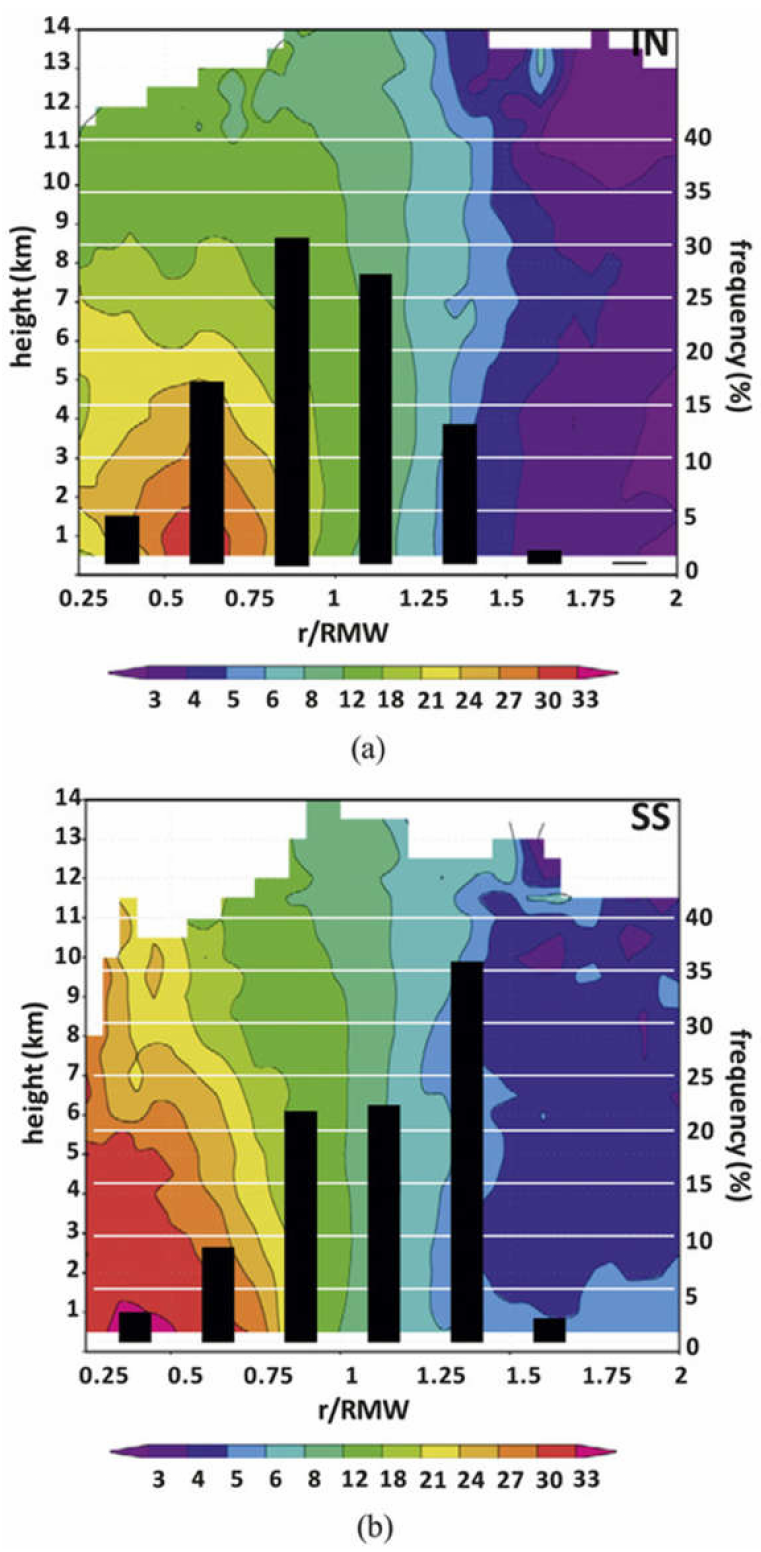
Figure 5. Frequency of convective burst points as a function of normalized radial location (bar chart, %) overlain on normalized radius-height plot of composite-mean axisymmetric vertical vorticity (color shaded, × 10 − 4 s − 1 ) for the ( a ) intensifying (IN) and ( b ) steady-state (SS) TC composites. Adapted from Rogers et al.